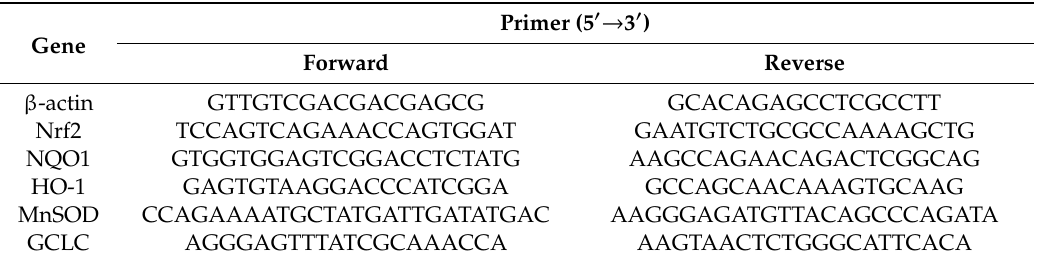
Primer (5 (cid:48) → 3 (cid:48)